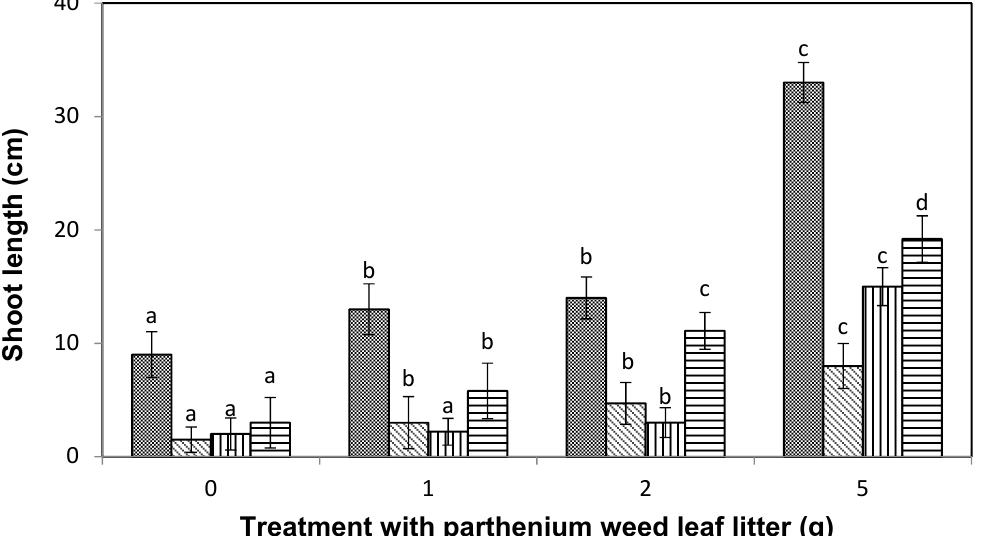
Figure 4. Seedling emergence of lettuce ( ), maize ( ), curly windmill grass ( ), and liverseed grass ( ) when sown into compost amended with different amounts of parthenium weed leaf litter (either 0, 1, 2, or 5 g) for 30 days. Error bars represent two standard deviations from the mean as calculated for three replicates of three seedlings. Means within each treatment that do not share the same letter are significantly different from one species to another at p > 0.05.